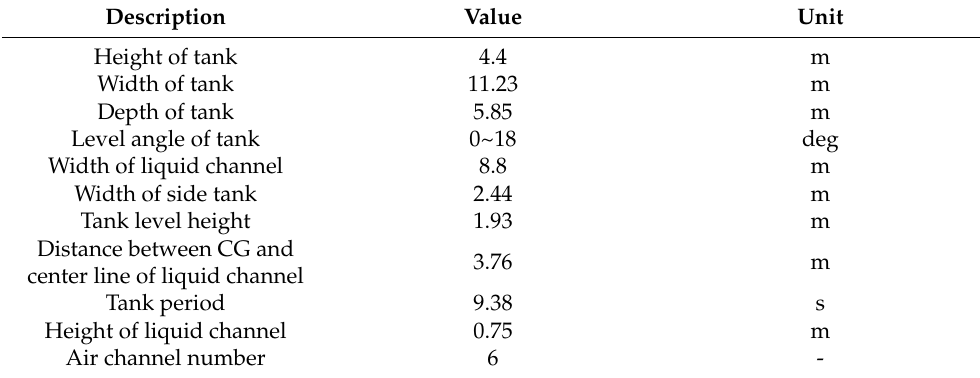
Table 2. Parameters of the anti-rolling